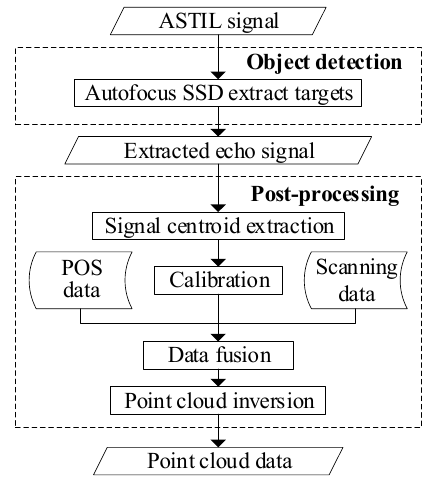
Figure 4. ASTIL fast-processing system.